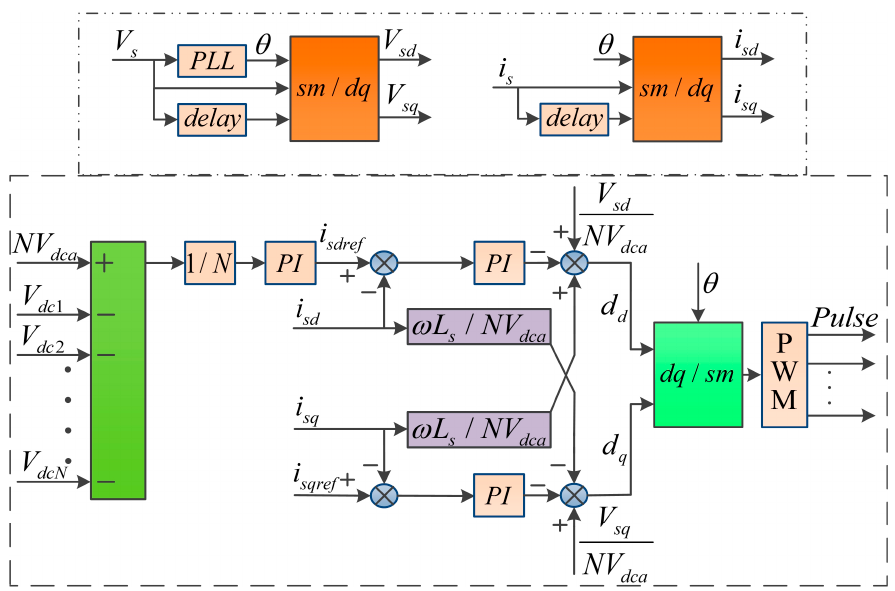
Figure 2. Control block diagram of the original system controller (OSC).